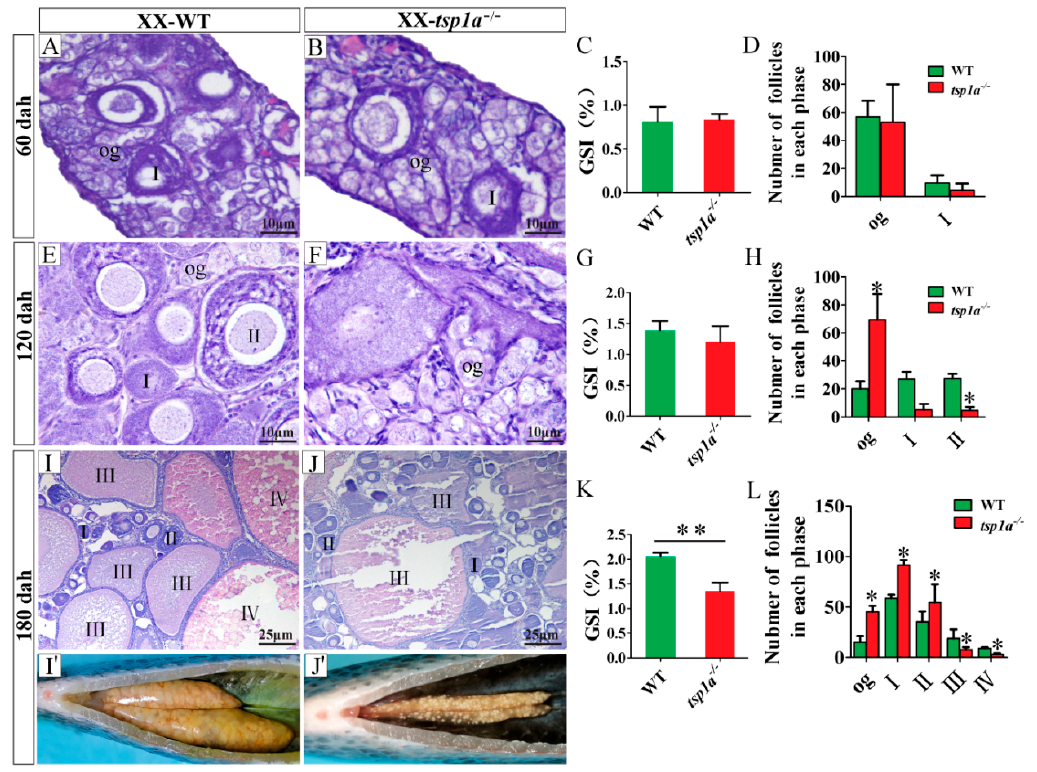
Figure 3. Morphological and histological analyses of WT and tsp1a − / − ovaries at 60, 120 and 180 dah. ( A , B , E , F , I – J’ ) Morphological and histological observation. ( C , G , K ) Gonadosomatic index (GSI) ( n = 5). ( D , H , L ) Statistical analysis of oocyte counting ( n = 5). Differences between the mutants and WT were tested by two-tailed unpaired Student’s t-test, * P < 0.05; ** P < 0.01. Results were presented as the mean ± SD in C-D, G-H, and K-L. dah, days after hatching. WT, wild type. Og, oogonia. I to IV, phase I to phase IV follicles.